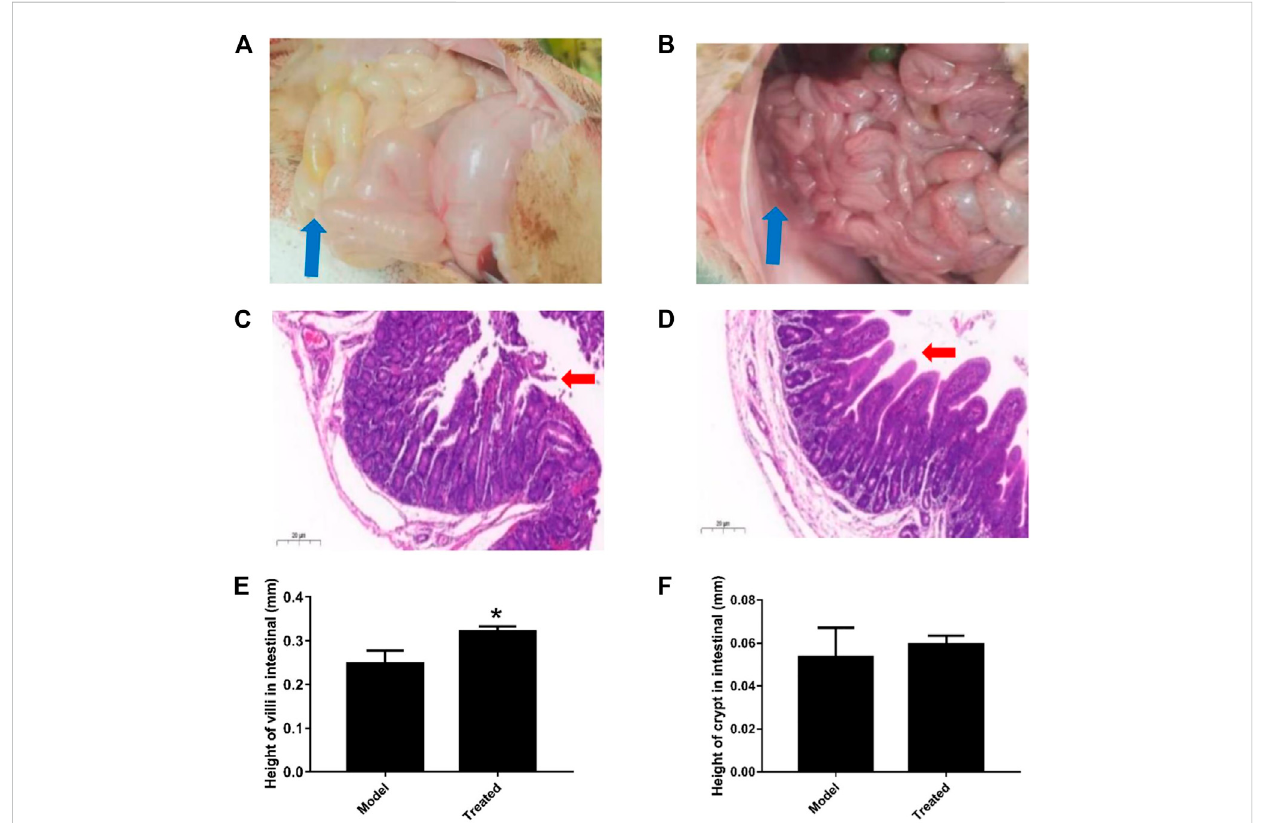
FIGURE 7 Effect of HJ on the macroscopic and histological changes of piglets infected with PEDV. Piglets received HJ (1.28 g/kg) by oral administration for 6 days before PEDV-G2 (5 mL DMEM containing l0 5 PFU) infection. The intestinal microscopic lesions of piglets in the model group (A) and the treated group (B) were recorded before sampled. The thin-wall intestinal tracts containing undigested food were indicated by blue arrows. The histological changes of intestine ofpigletsin themodel group (C) and thetreated group (D) were analyzed by hematoxylin-eosin (HE) staining. The damage and shedding of intestinal villi were indicated by red arrows. The height of villi (E) and crypt (F) in HE staining were measured to evaluate the growth and development of intestinal. Data are represented as mean ± SD, n = 3. *, and p < 0.05 was considered statistically signi fi cant compared with the model